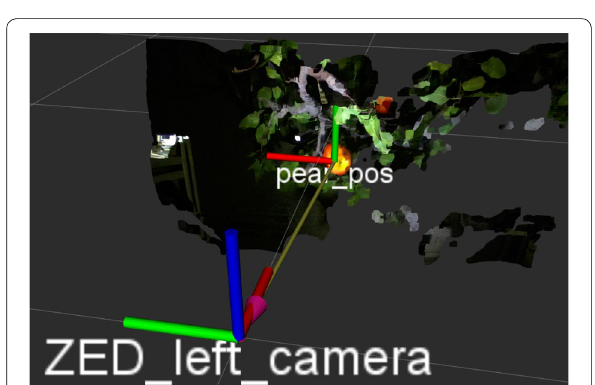
Fig. 13 Detection of three-dimensional position